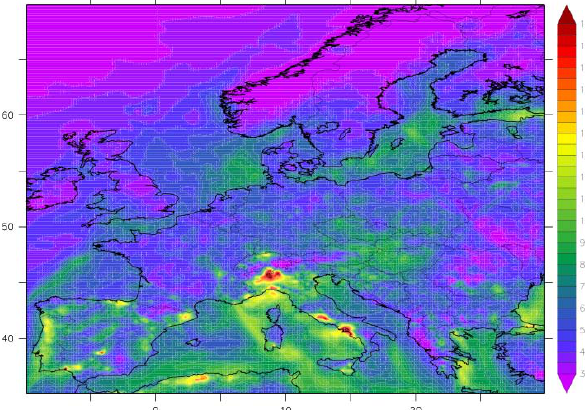
Fig. 6. Estimated standard deviations (in ppb), averaged in the period between 1 and 10 July 2010.